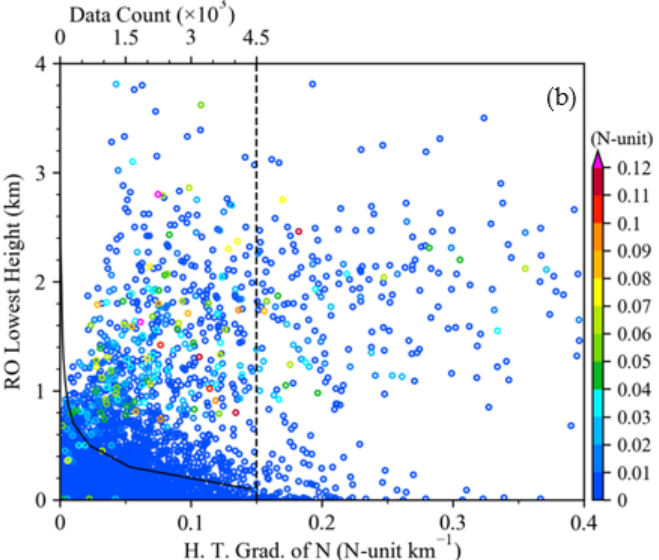
Figure 12. Scatter plots of the RO lowest heights versus the along-the-track horizontal gradient of refractivity in the tangent direction at the perigee point (H. T. Grad. of N ) for ROs with their vertical gradients of N − N ( r ) less than − 65 N-unit km − 1 in August 2020 over ( a ) the SEP and ( b ) SCP areas. The cloud contribution to the refractivity (i.e., N cloud ) at the RO lowest heights is indicated in colors, and the number of the lowest RO data with the “H. T. Grad. of N ” being less than 0.15 N-unit km − 1 (black dashed line) at 0.2-km interval is shown by black curve.